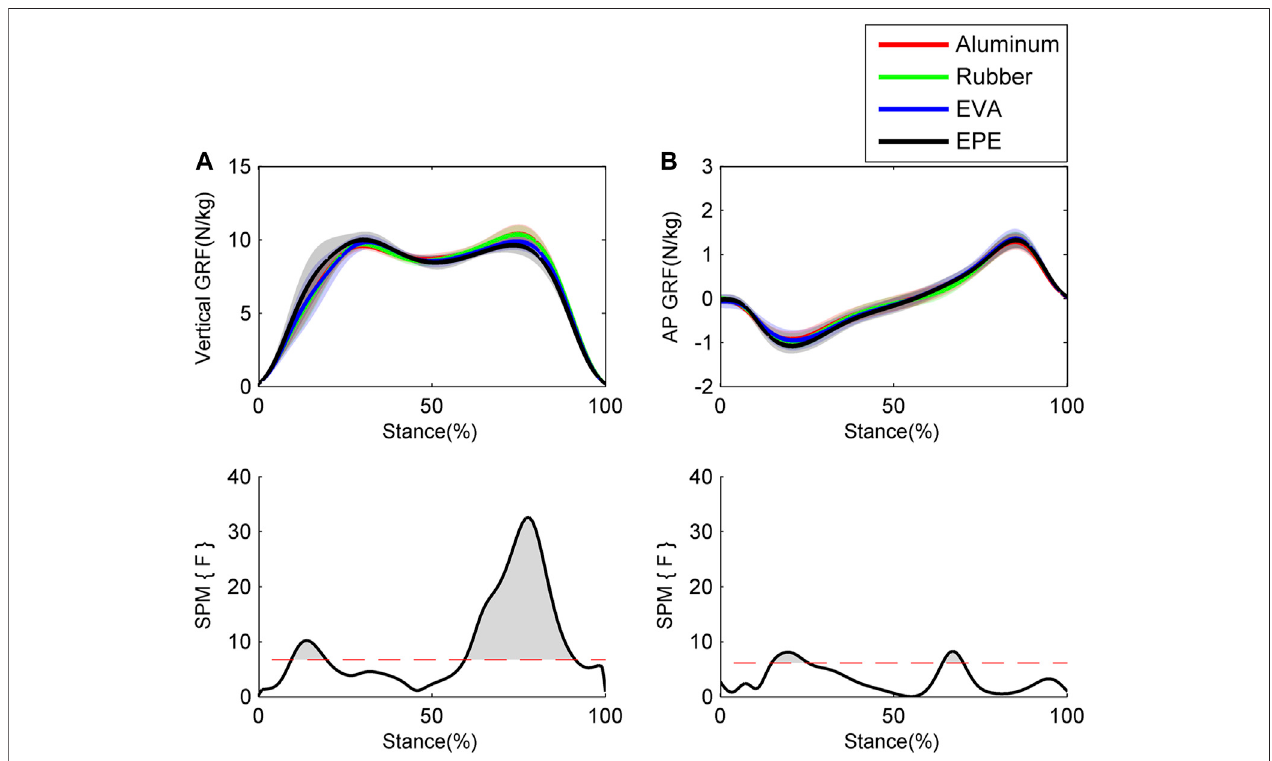
FIGURE4 | Ensemble average curves (continuous line) and standard deviation (shaded area) for GRFs during walking: (A) vertical GRF; (B) anterior – posterior (AP) GRF. Data are reported for the stance phase of walking with 0% being heel strike and 100% being toe-off events. The shaded areas in the SPM fi gure indicate that signi fi cant difference was found ( p < 0.05) during this